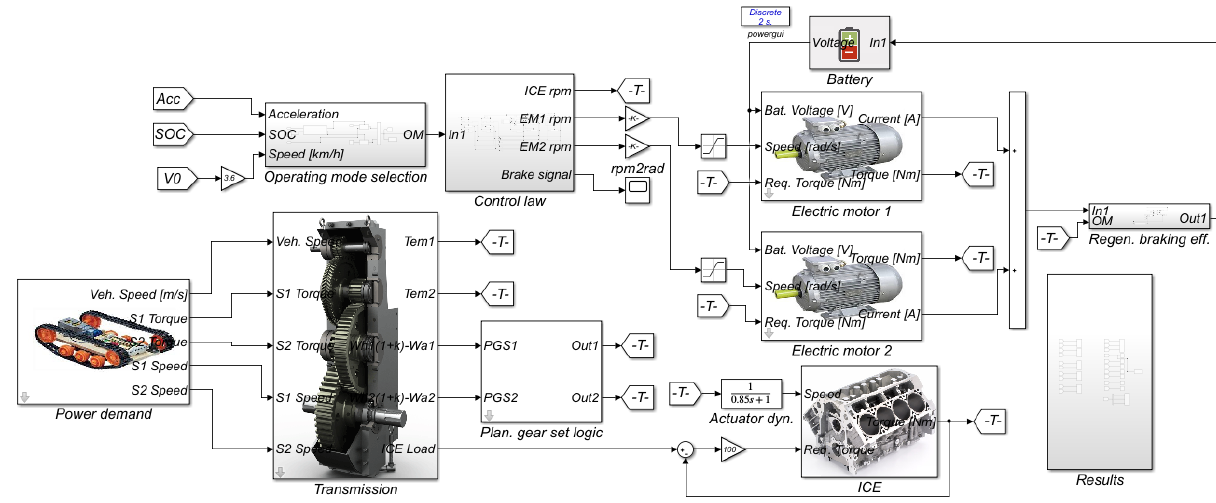
Figure 8. Vehicle model in